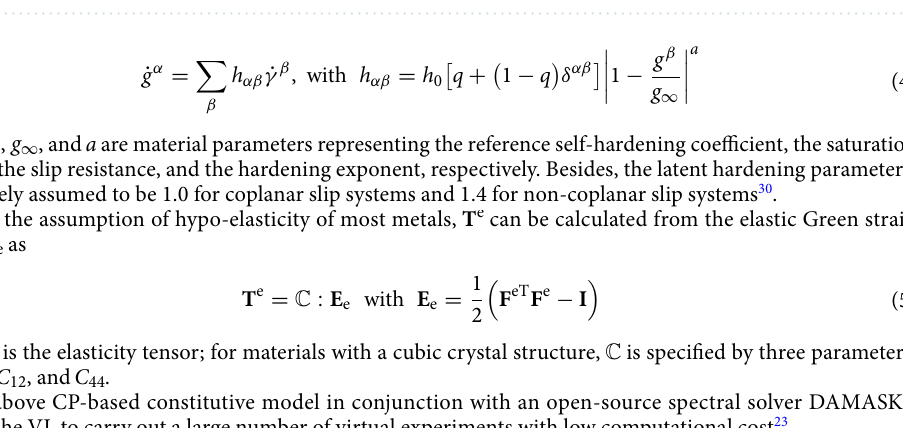
Figure 1. ( a ) The high-resolved dual-phase RVE (DP-RVE) used for CP simulations; red color represents the martensite phase and blue the ferrite. ( b ) and ( c ) are the separated ferrite and ( c ) martensite phases colored with the RD